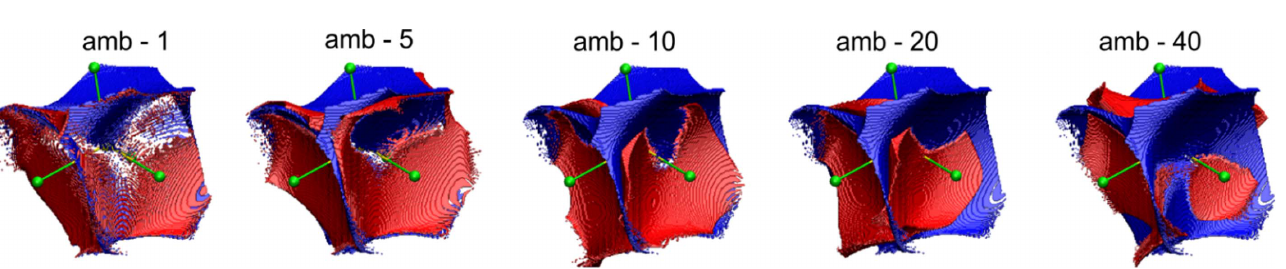
Figure 9 Sulfur atomic basin and the evolution of its shape as a function of